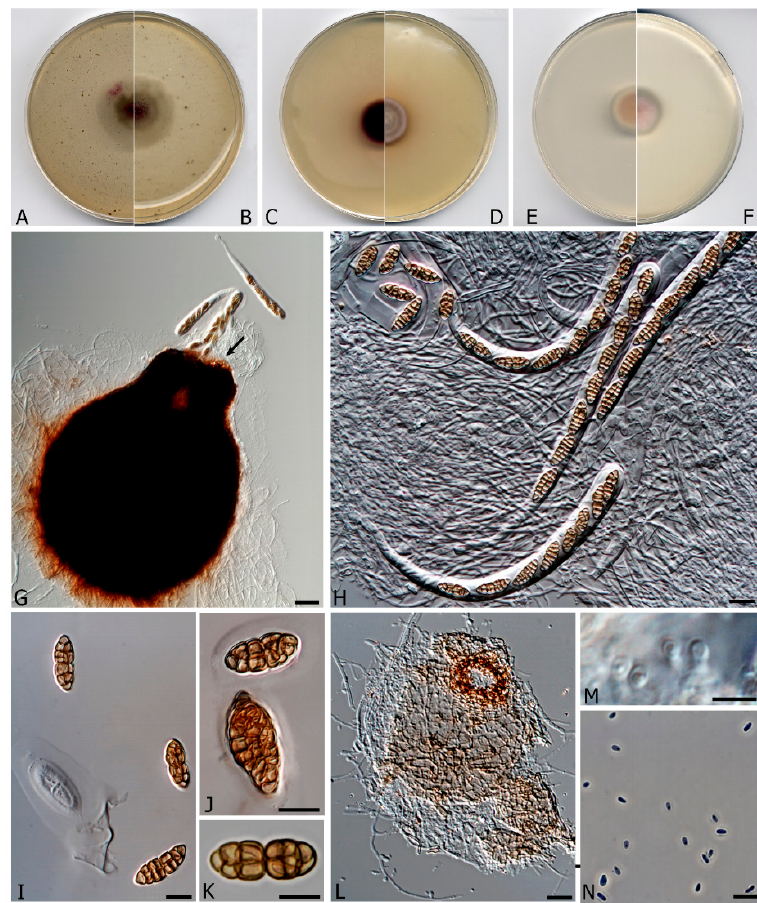
Figure 3. Murispora fissilispora CBS H-24462. ( A , B ) Colonies on OA (reverse and front), ( C , D ) MEA 2%(reverse and front), ( E , F ) PDA (reverse and front). All media at 15 °C after 3 weeks. ( G ) Ascomata expelling asci. ( H ) Asci. ( I – K ) Ascospores (Note the mucilaginous sheath in I and J). ( L ) Pycnidia. ( M ) Conidiogenous cells. ( N ) Conidia. Scale bars: G = 25 µ m, H–N = 10 µ